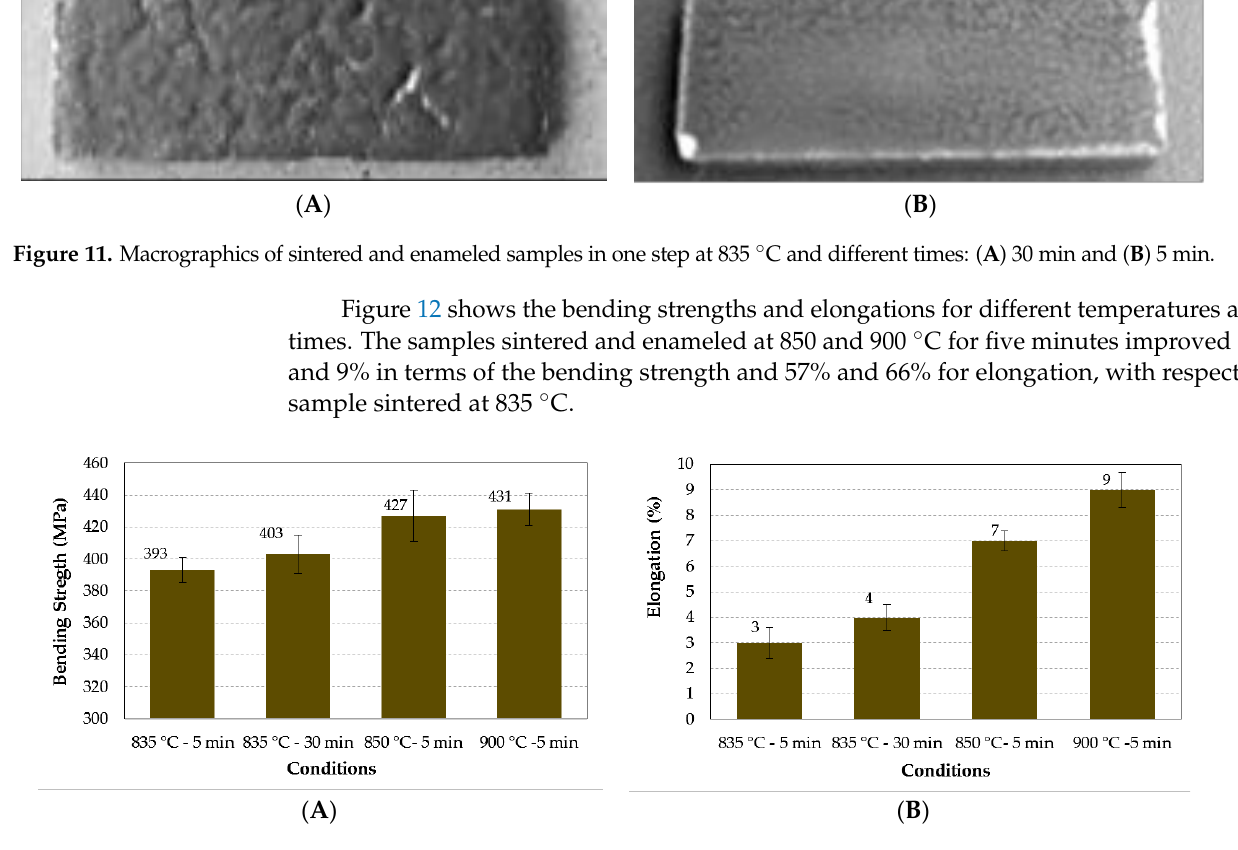
Figure 12. Samples sintered and enameled in one step at different temperatures and times: ( A ) bending strength and ( B ) elongation (compaction pressure 500 MPa).